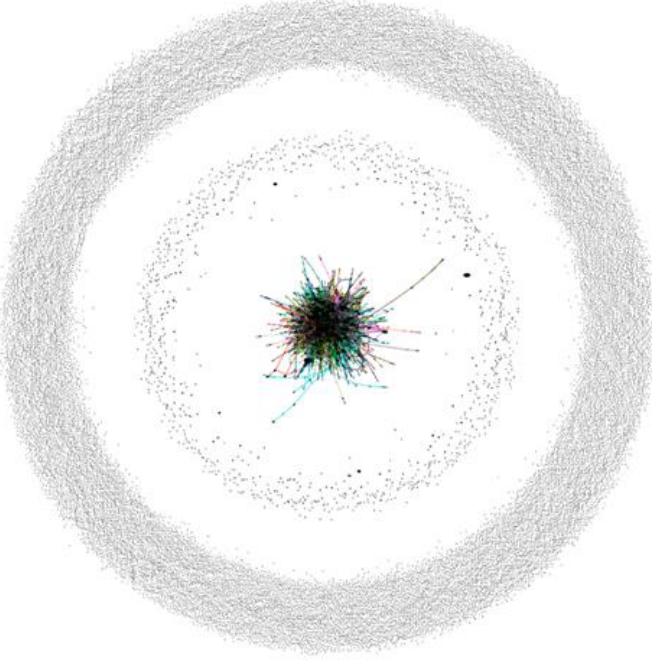
Figure 1. Network of interactions